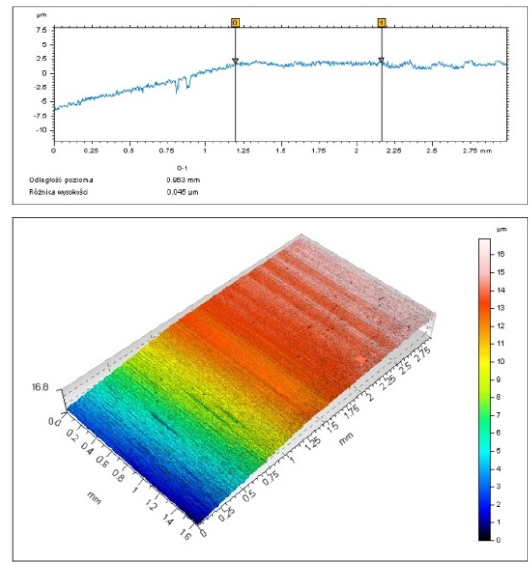
Figure 7. A 3D surface image and the corresponding 2D profile for a sample cut at v c = 360 m/min and f = 0.03 mm/rev using an insert with an edge radius of 49.9 µm. Micromachines 2020 , 11 , x